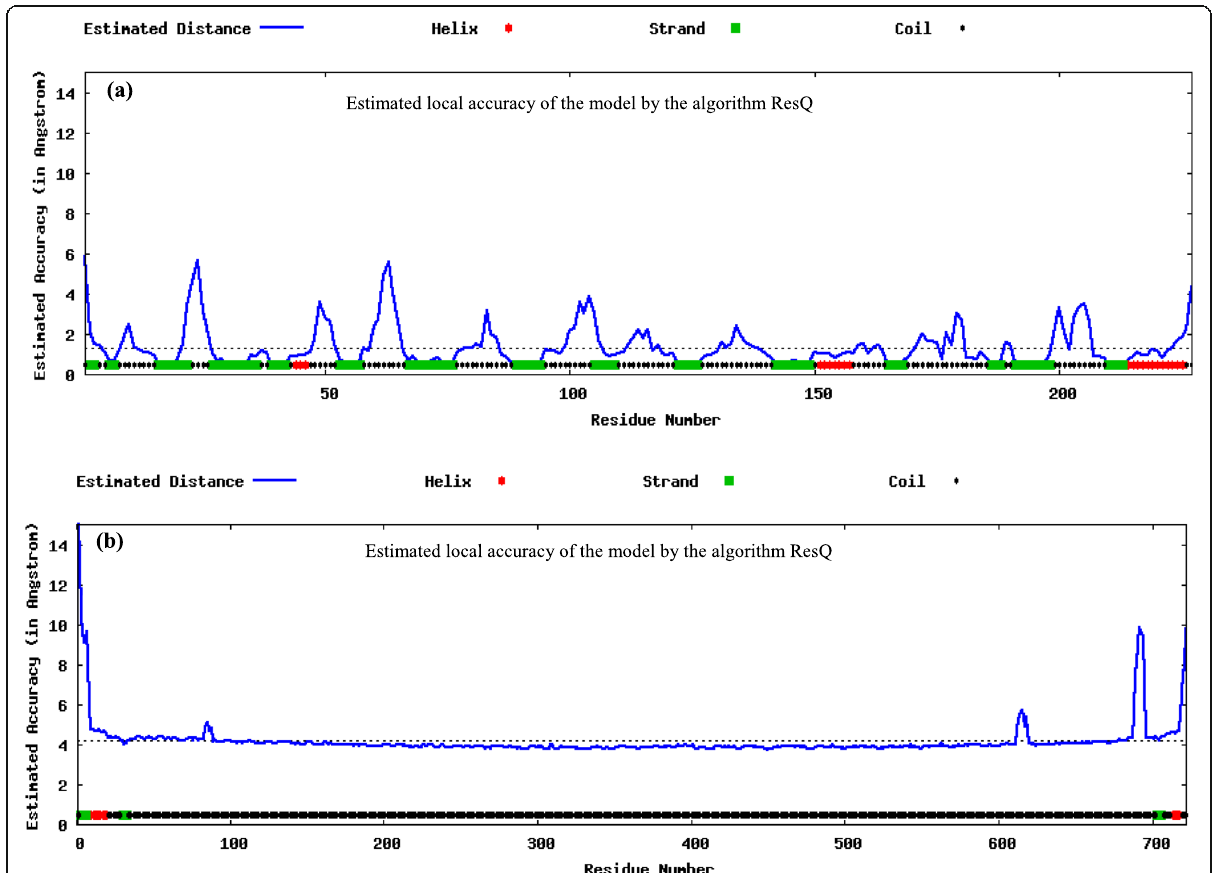
Fig. 4 Cocoonase ( a ) and sericin ( b ) showing the local accuracy estimation for the first model predicted by I-TASSER. Also, majority of residues in the models are modeled accurately with estimated distance to native below 2 A° for cocoonase and below 6A° for